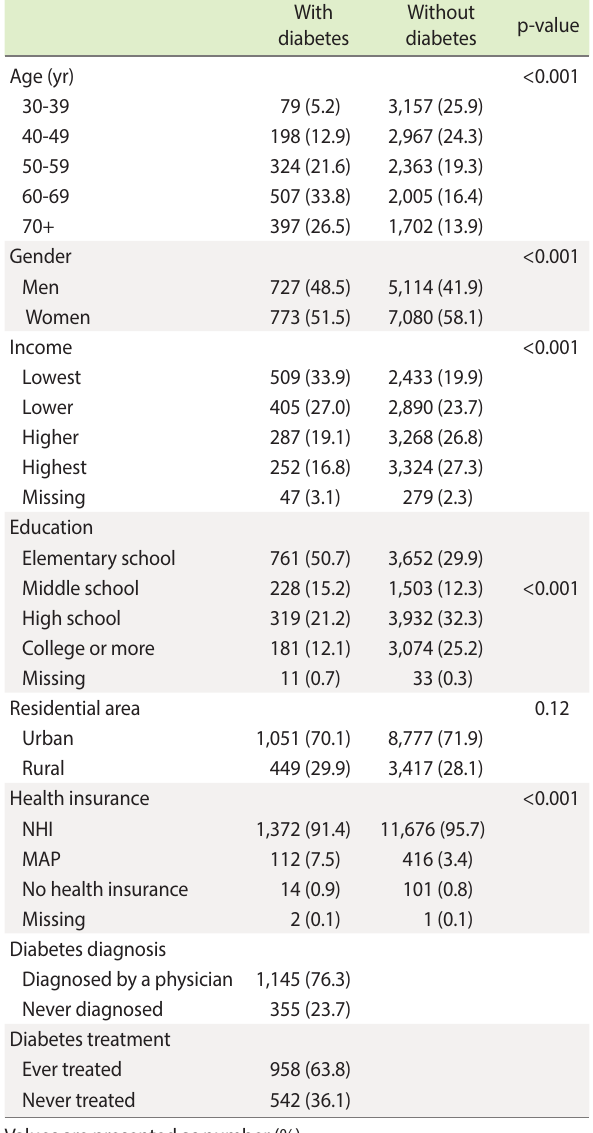
Table 1. Socio-demographic characteristics of the study partici- pants in the KNHANES, 2007-2009